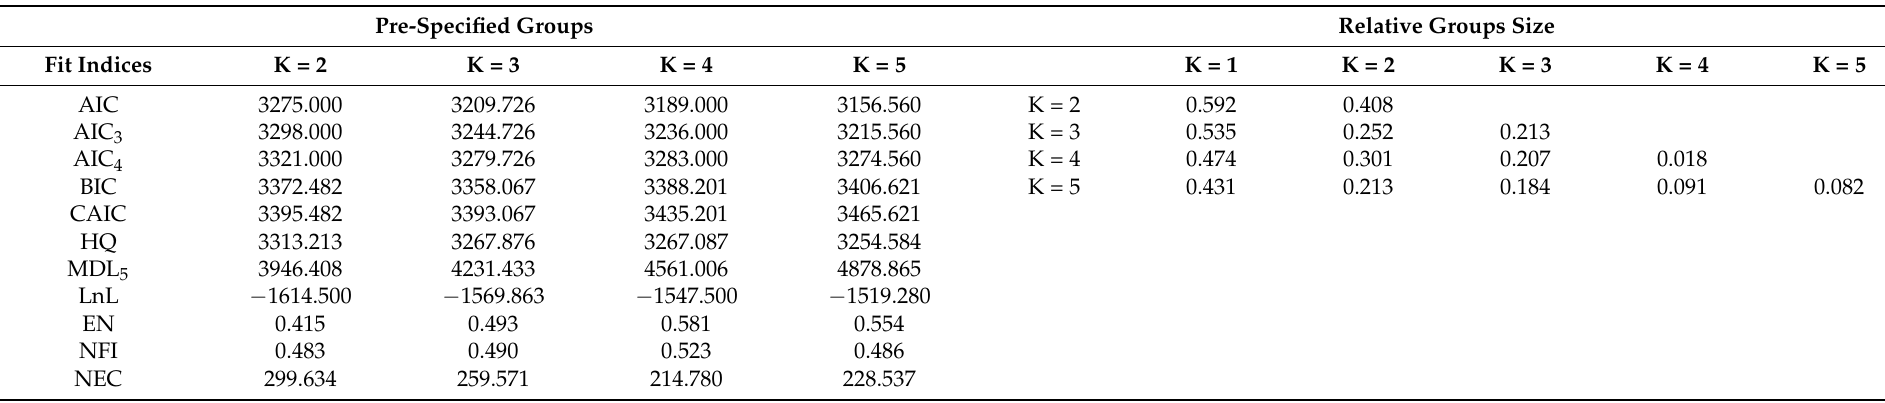
Table 4. Pre-specified groups and relative group sizes.